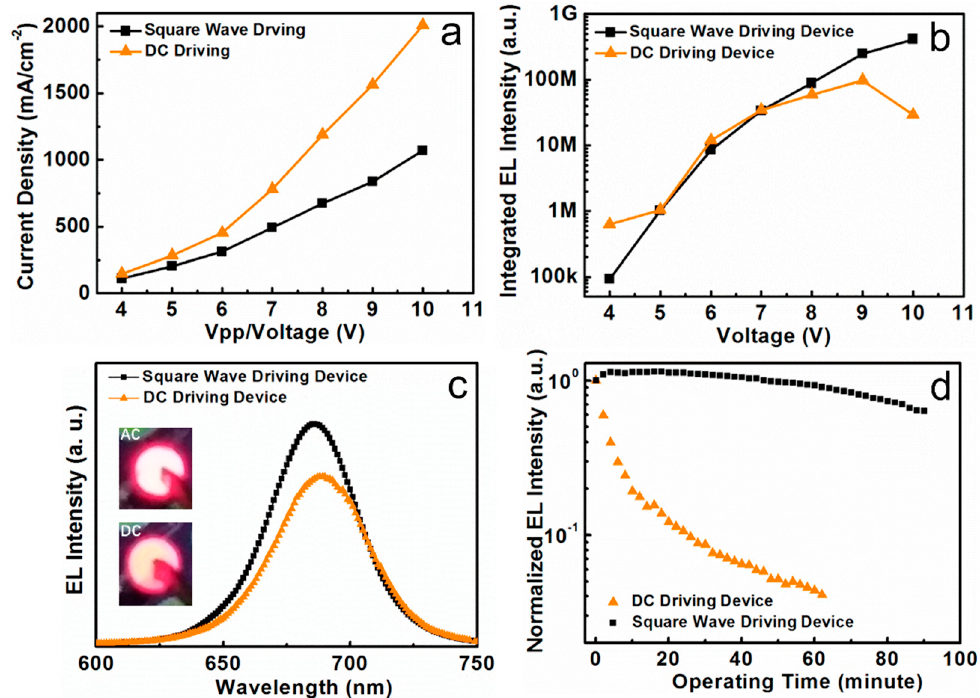
Figure 6. ( a ) Density-voltage curve of the CsPbI 3 QDs LEDs under DC and AC (square pulsed bias, duty cycle: 50%, frequency: 10 Hz) driving conditions; ( b ) Integrated EL intensity of CsPbI 3 QDs LEDs with different voltages under DC and AC driving conditions (square pulsed bias, duty cycle: 50%, frequency: 10 Hz); ( c ) The EL intensity of devices under DC (8 V) and AC (square pulsed bias, duty cycle: 50%, frequency: 10 Hz, Vpp: 8 V) driving conditions. The insets are the digital pictures showing the red-light emission from devices under AC and DC driving conditions; ( d ) Normalized emission decays of the PeLEDs after different running periods under DC (8 V) and AC (square pulsed bias, duty cycle: 50%, frequency: 10 Hz, Vpp: 8 V) driving